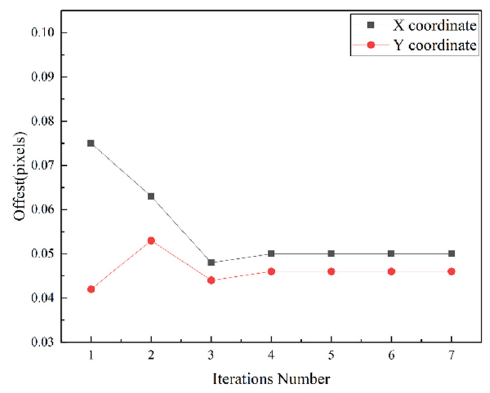
Figure 7. Deviation of the center locating results of several algorithms from the true center in the x- and y-directions.